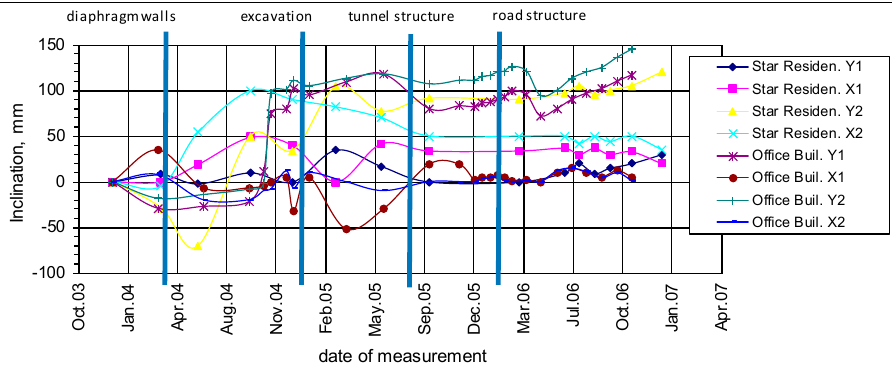
Figure 13. Settlement of selected objects measured on benchmarks (construction of the tunnel under the roundabout in Katowice—objects with small settlements).